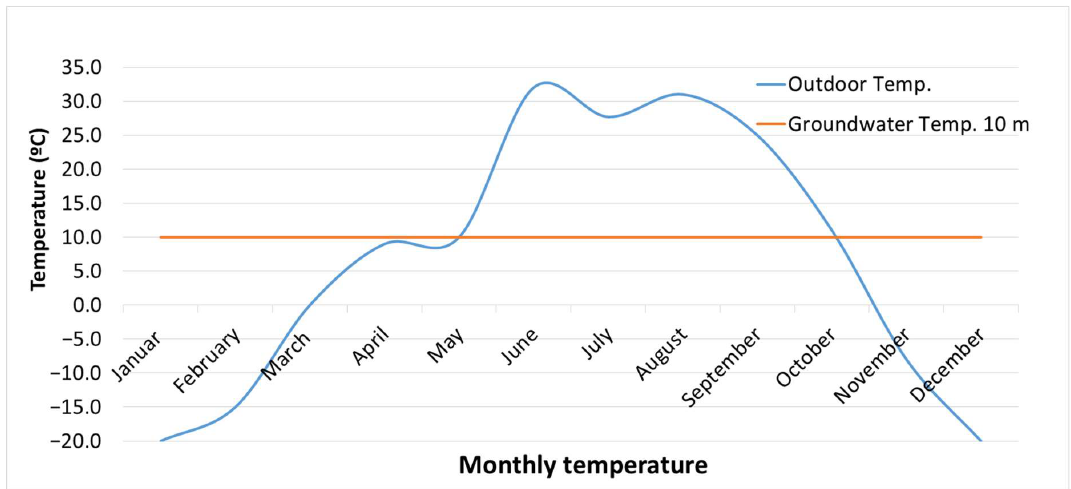
Figure 3. Groundwater temperatures chart at a depth of about 10 m.